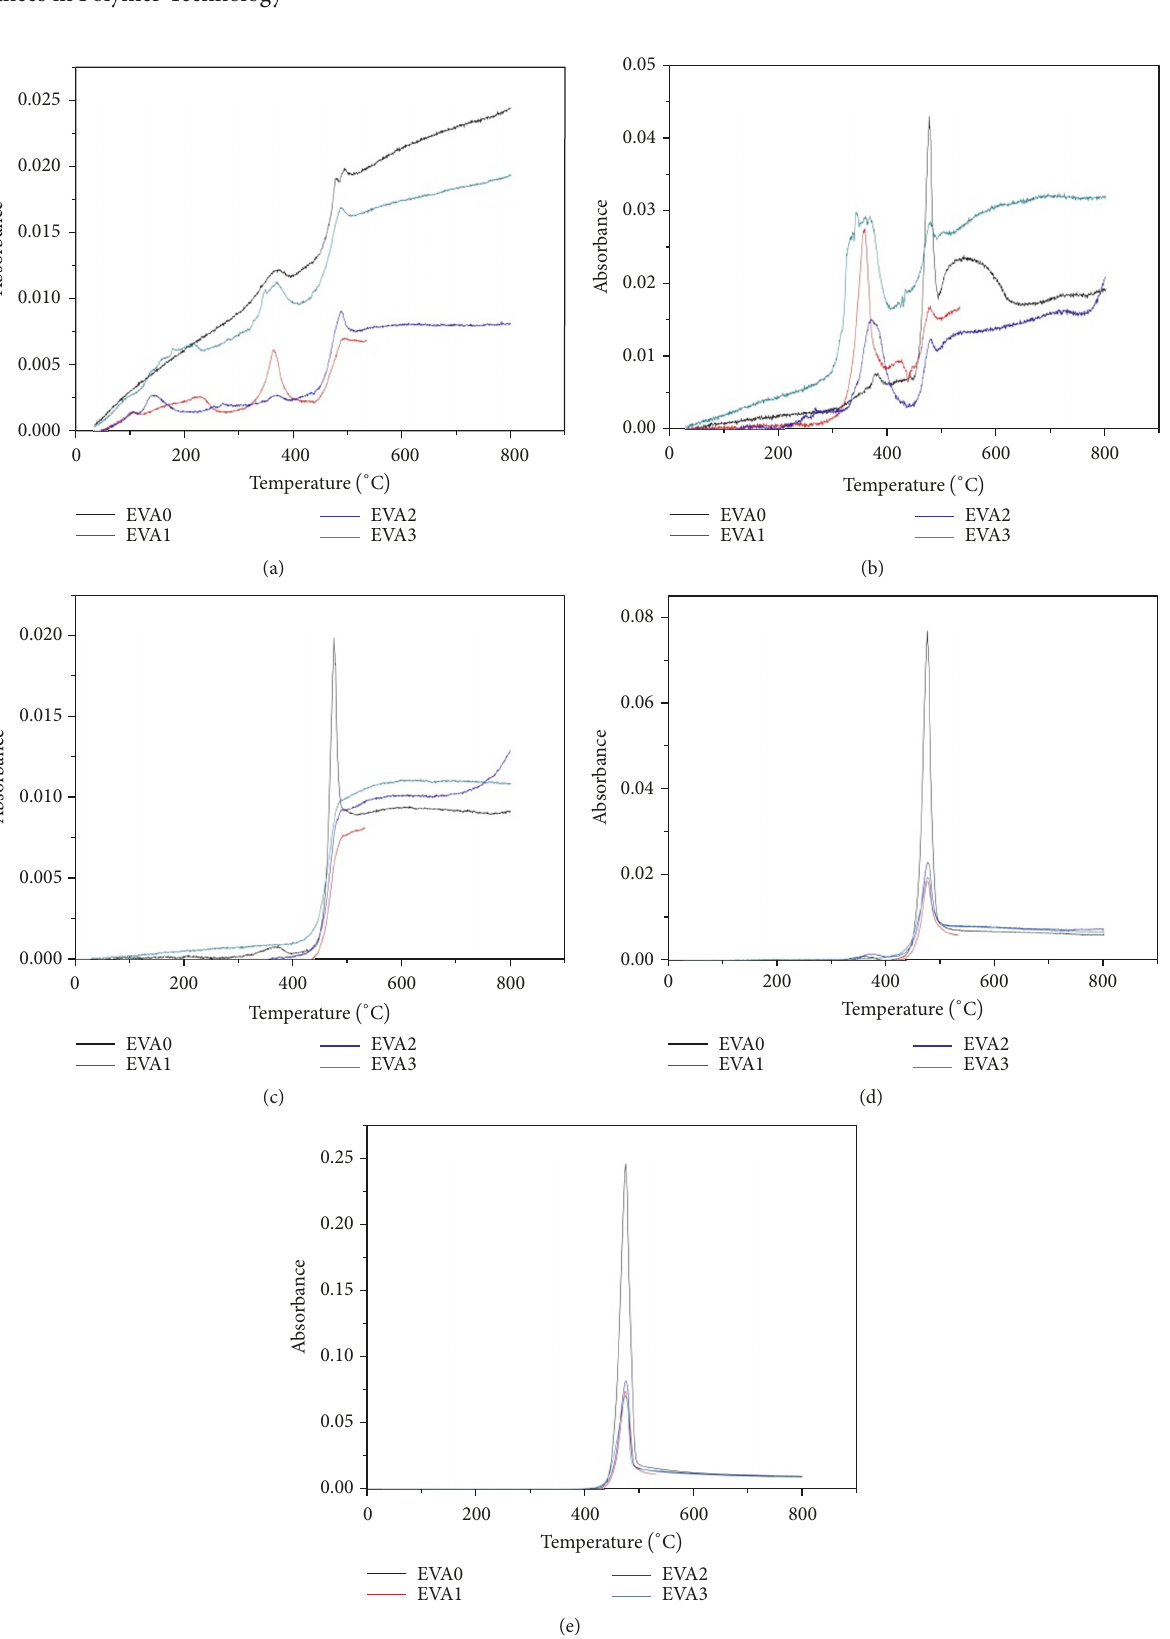
Figure 13: Variations in the evolved (a) H 2 O, (b) CO 2 , (c) CO, (d) carboxylic acid, and (e) aliphatic hydrocarbons gases from EVA0, EVA1, EVA2, and EVA3